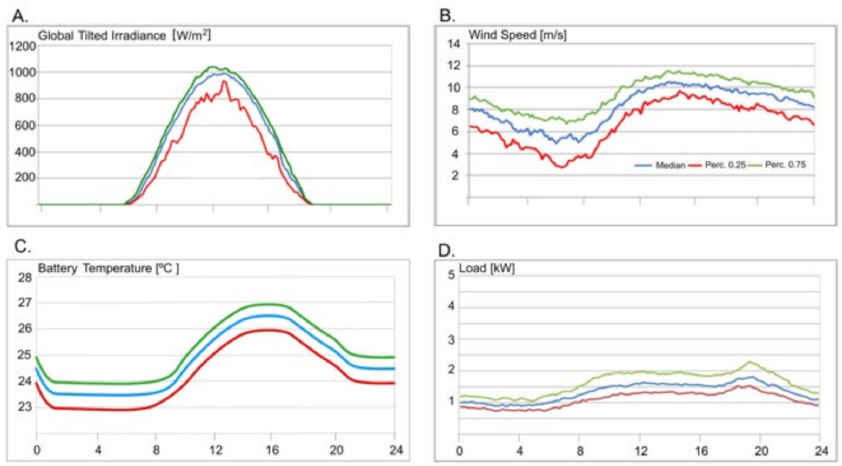
Figure 6. ( A ): Hourly profiles of GTI; ( B ): Hourly profiles of wind speed; ( C ): Hourly profiles of battery temperature; ( D ): Hourly profiles of